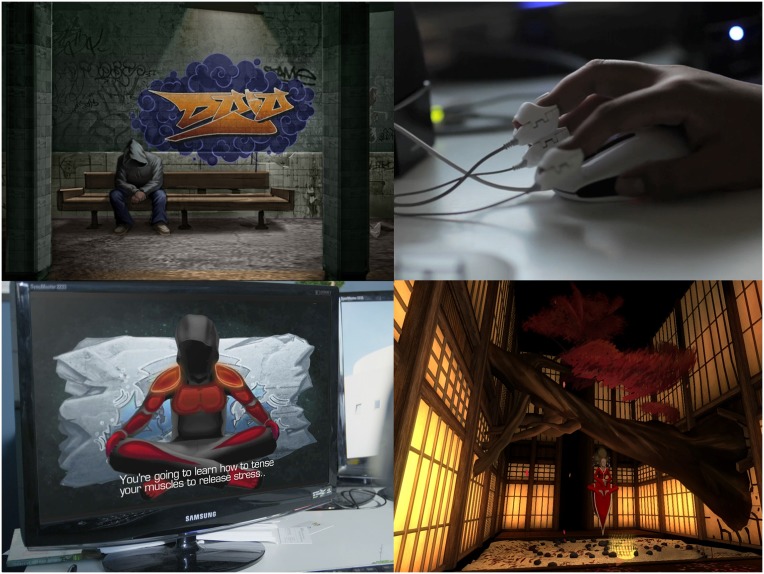
Screenshots Dojo.